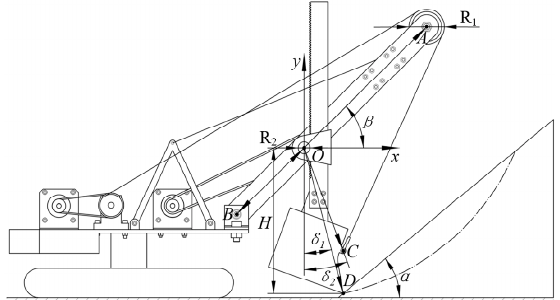
Figure 2. Structural parameters of the ECS scale model: R 1 – boom point sheave diameter; R 2 –crowd gear diameter; l AB –boom length; l OB , l OC , l OD –the distances from the rotation center of the saddle to the bottom of the boom, the hoist beam, and the tooth tip; H– height of saddle rotation center from tooth tip; α –material angle of repose; β –angle between boom and horizontal direction; δ 1 , δ 2 –angle between l OD , l OC and the parallel direction of the dipper handle. Table 1. Structural parameter values.